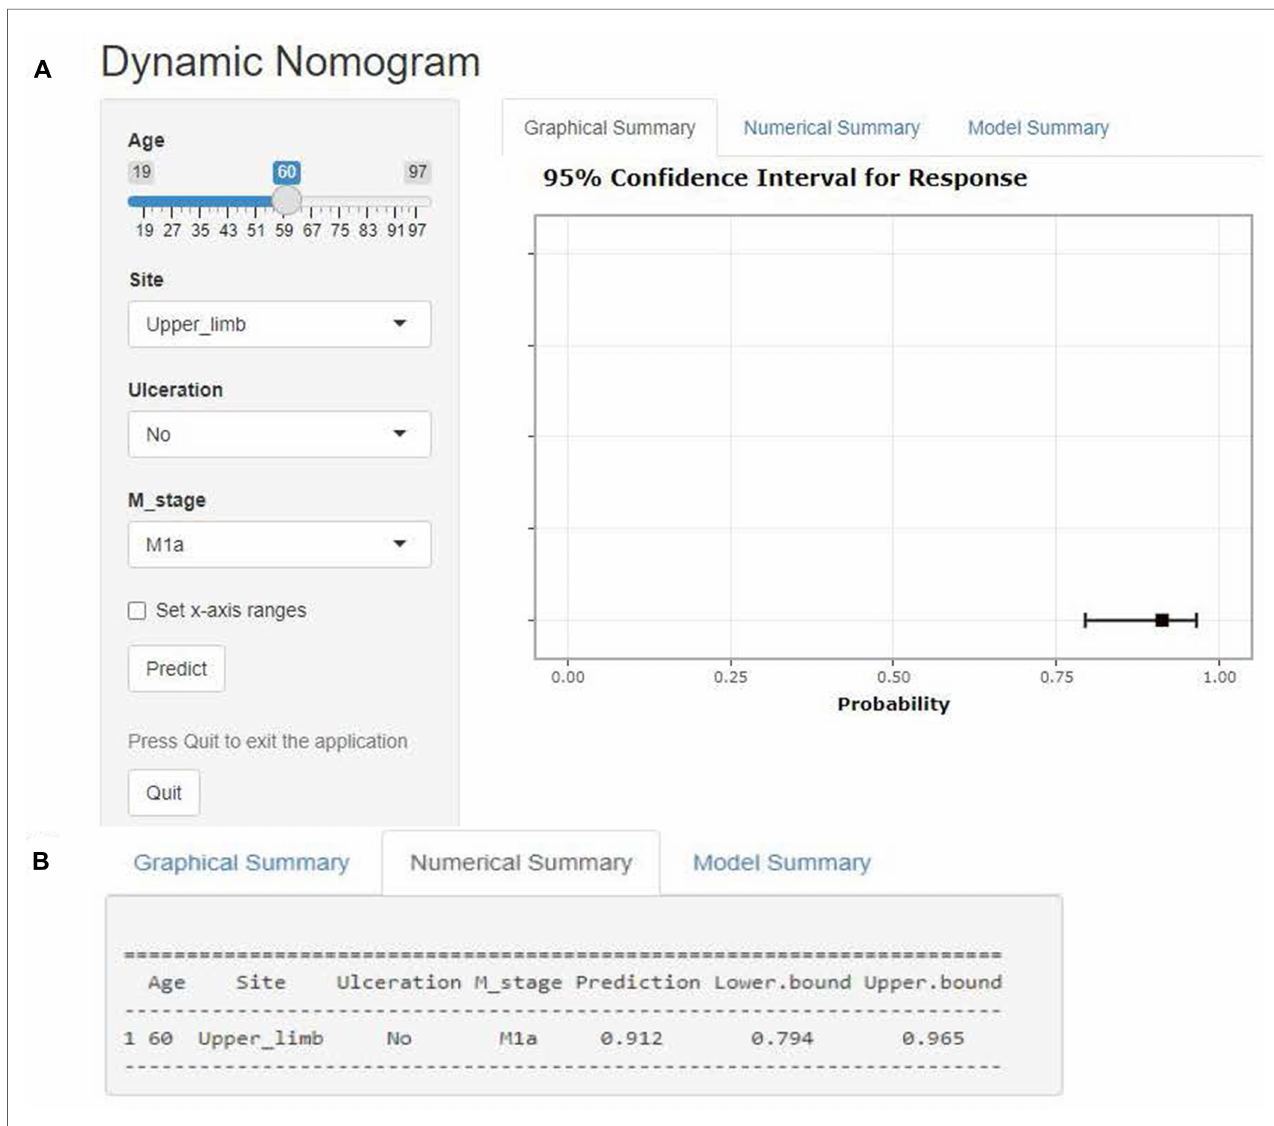
FIGURE 7 Web-based nomogram. Illustrate the web-based nomogram through an example. A stage IV CM patient has clinicopathological features: 60 years old, stage M of M1a, primary tumor location in the upper limb, and no ulceration at the primary site. Patient characteristics are shown on the left side of the network nomogram ( Figure 5A left). The graphical summary ( Figure 5A right) and the numerical summary ( Figure 5B ) show the probability line and the exact numerical value of the bene fi t (probability of surgical bene fi t of primary focus=0.912, 95% CI=0.794 – 0.965),